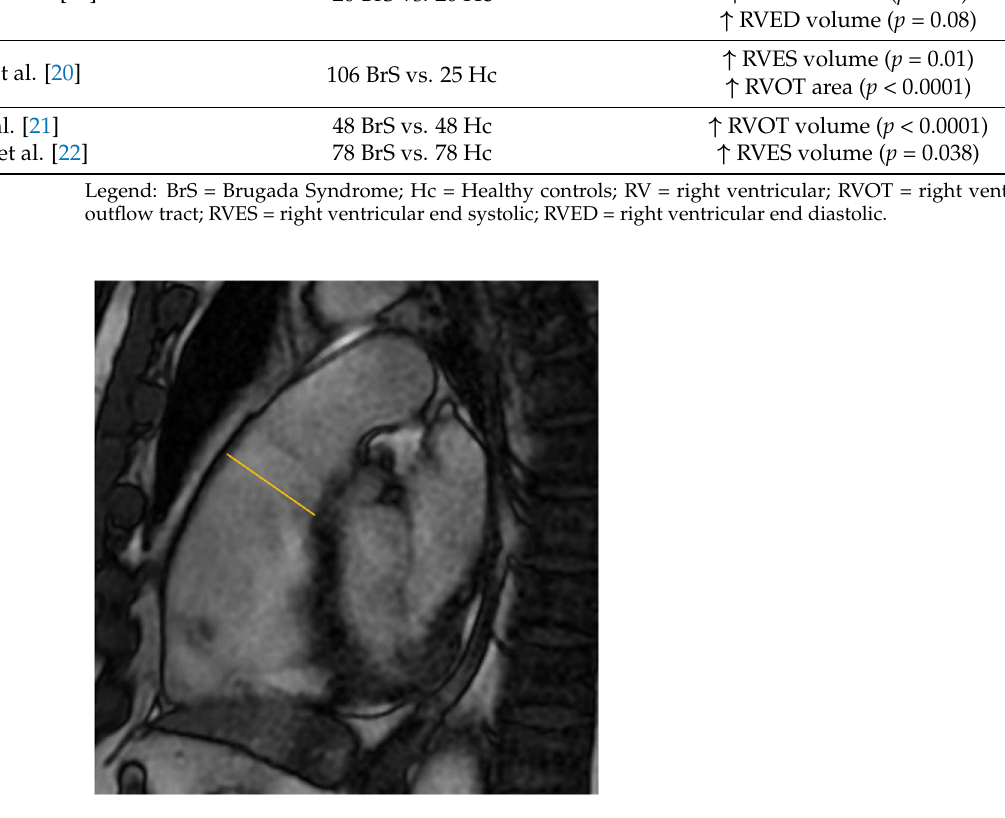
Figure 2. Right ventricular out fl ow tract: cine-CMR focused on dilated RVOT as measured in orange. Table 3. CMR fi ndings about RV dimension in BrS.